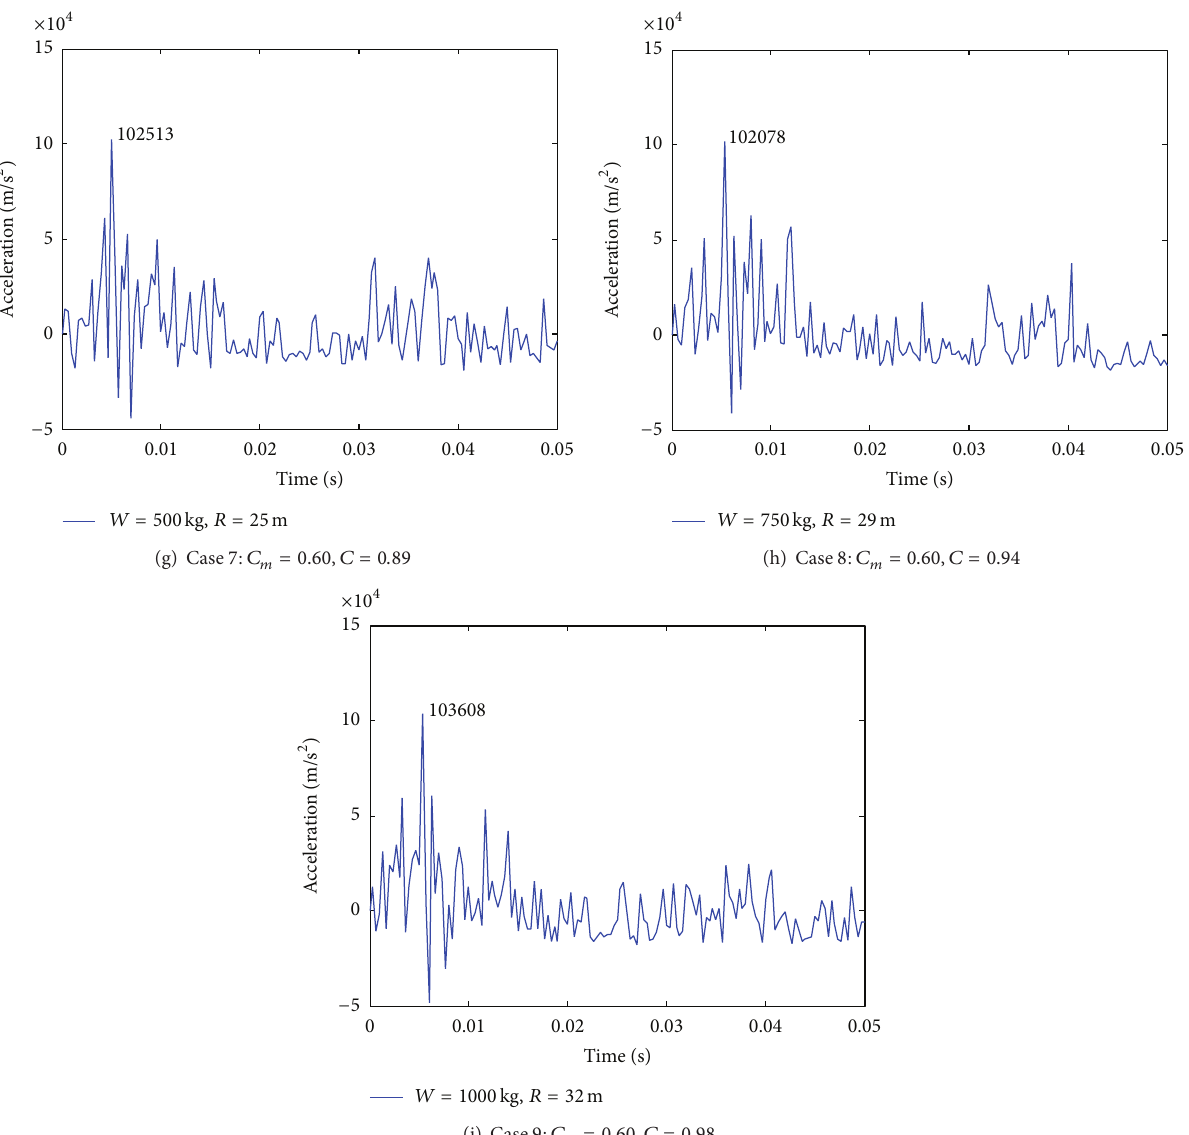
Figure 9: The time history of dynamic acceleration of cylindrical shells.